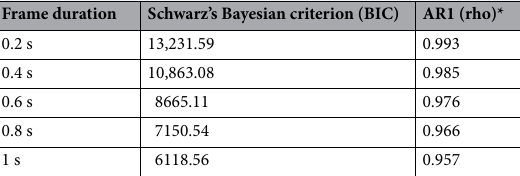
Table 2. Correlation between the SUF and UF flow rate. *Calculated from the correlation matrix for estimates of covariance